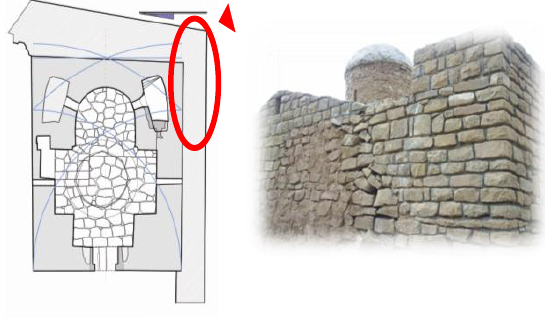
Figure 14. Incorrectly restoration